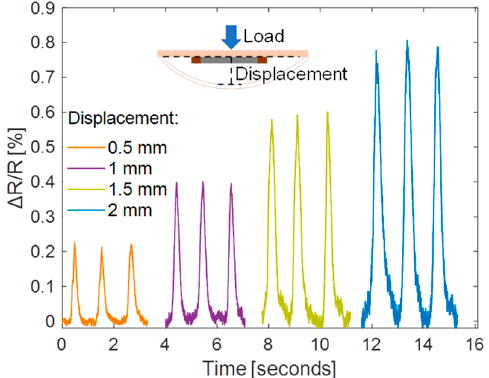
Figure 9. The normalized sensor resistance change at different displacement levels.